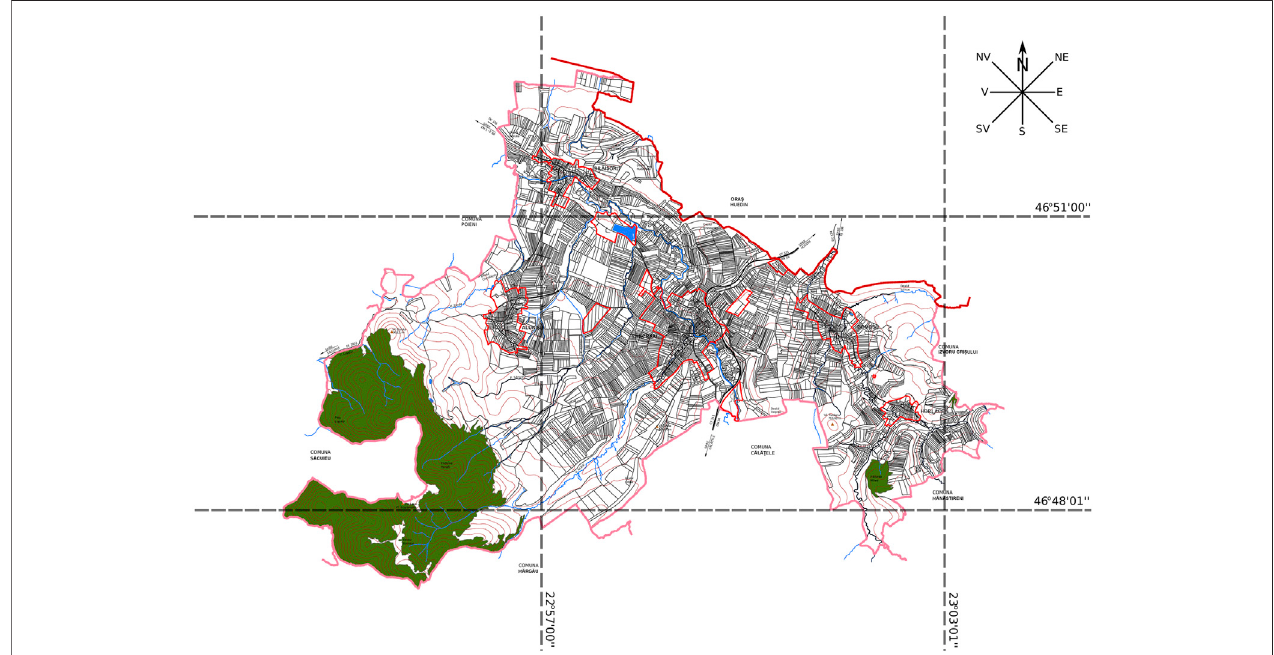
FIGURE1| Thepublicly availablemap ofcommuneSancraiu(Cluj, Romania).Themappresentstheboundariesofthecommune,theneighboringcommunesand city along with the constituent villages, intra-village territory, and agricultural land parcels. Courtesy of Sancraiu Mayor ’ s of fi ce.